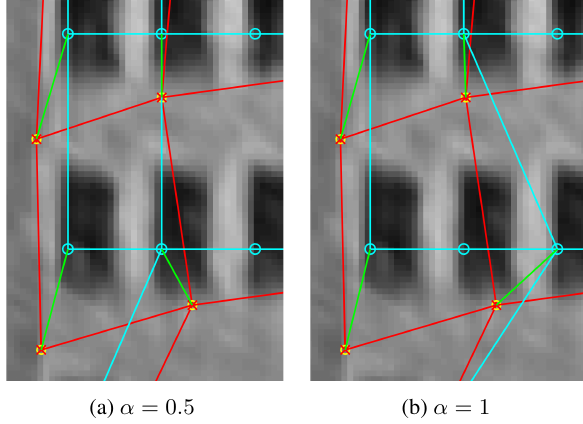
Figure 9: Cut out detail of Figure 6. Influence of topology for (a) α = 0 . 5 and (b) α = 1 . Red lines: grouping result of PS in range- azimuth geometry, projected into the image. Green lines: Match- ing vectors between PS and lattice nodes. Cyan lines: topology of matched lattice nodes. Topology is consistent in (a) but not in (b). Persistent Scatterers are marked with red crosses while the final lattice nodes are given as cyan circles. The matching vectors are depicted in green. Even though the facade is partly covered by a different building in the optical image and some PS at the up- per region are induced by objects not being part of the regularity, the matching is meaningful. The lower left window corner